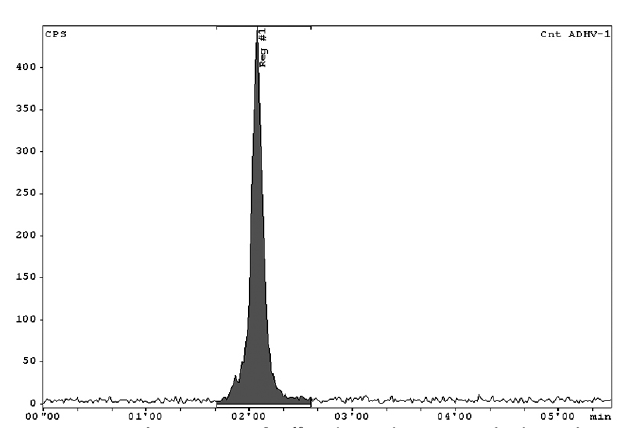
FIGURE 3 - HPLC chromatogram of Na 18 F solution showing its radiochemical purity, using NaOH 0.1M as mobile phase.